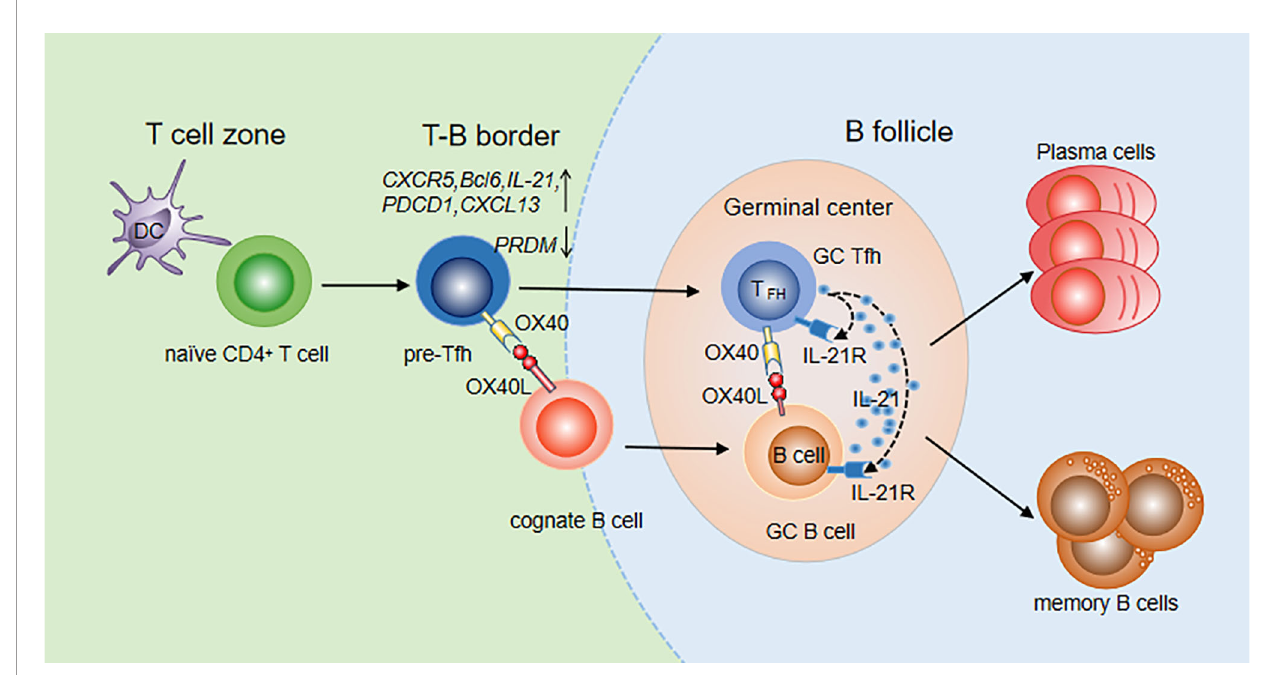
FIGURE 1 | OX40/OX40L signaling in Tfh differentiation and function. Tfh differentiation occurs at the time of DC priming. Upregulation of OX40 on pre-Tfh cells promotes their accumulation at the T-B border. With the interaction of cognate B cells, OX40 signaling contributes to Tfh maintenance, maturation and migration to B follicles. Meanwhile, B cells also move to B follicles to further interact with Tfh cells. Bidirectional OX40/OX40L signaling promotes both GC Tfh and GC B cell differentiation. With the help of GC Tfh cells, B cells differentiate into plasma cells and memory